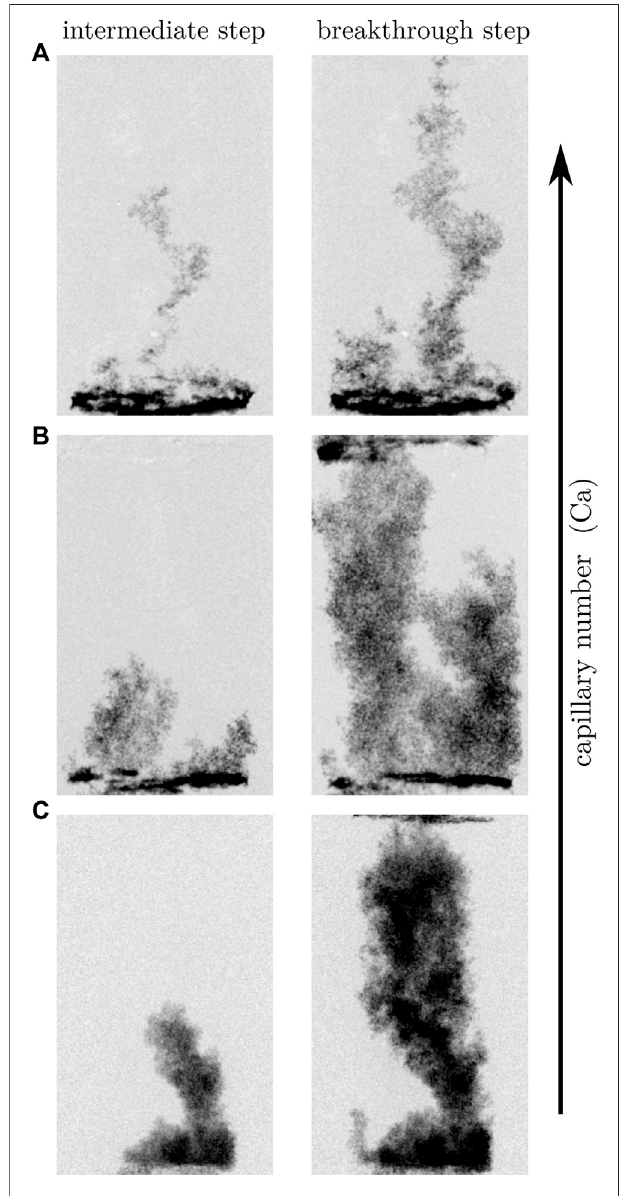
FIGURE 3 | Radiography representation of fi nger patterns at an intermediate and breakthrough step during injection of the invading (water) and defending (oil) fl uids. Experiments at three capillary numbers: log(Ca) = − 5.90 (A) log(Ca) = − 6.67 (B) and log(Ca) = − 7.67 (C) .